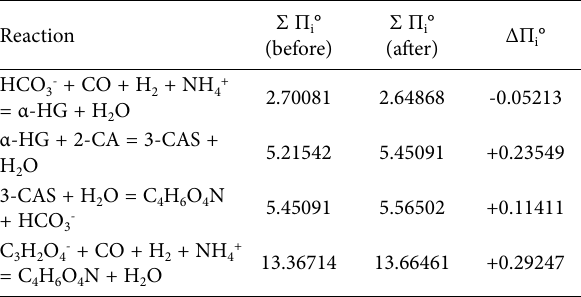
Table 8. Thermodynamic analysis of the abiotic synthesis of the aspartate aminoacid from malonate –OOC-CH 2 -COO-, carbon monoxide, ammonia and hydrogen gas. All values are given at pH = 7 and I = 0.25 M and reported in zJ·K -1 .